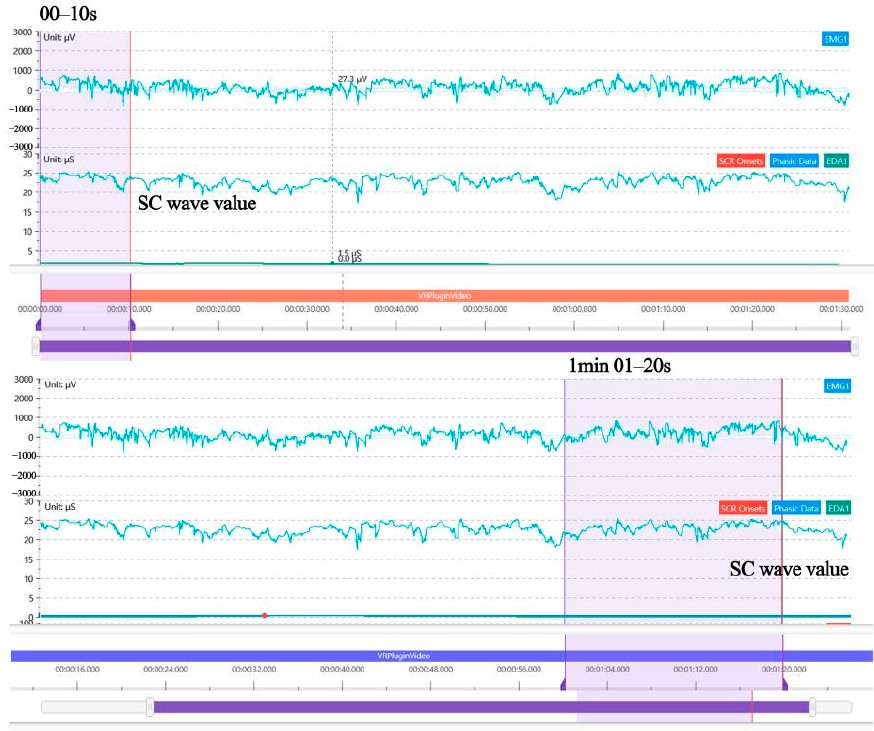
Figure 5. Extraction of SC fluctuation value. Source: Exported from ErgoLAB program.